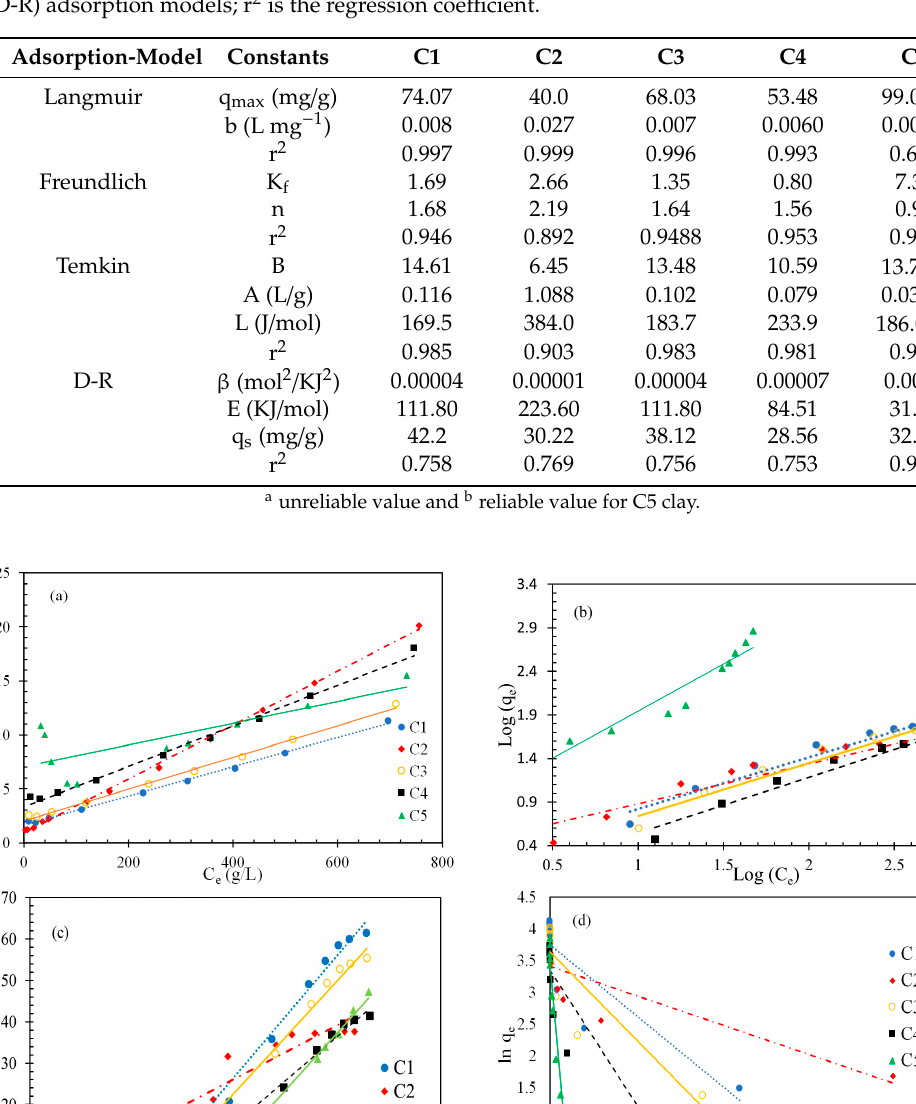
Table 4. List of estimated parameters from Langmuir, Freundlich, Temkin and Dubinin–Radushkevich (D-R) adsorption models; r 2 is the regression coe ffi cient.